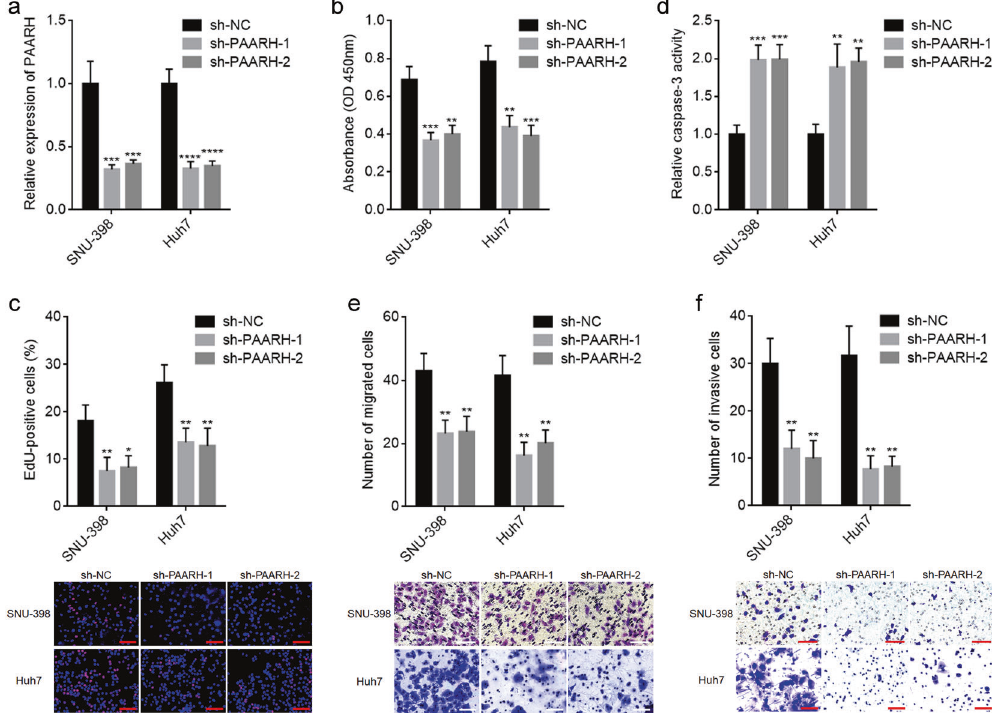
Fig. 3 PAARH silencing reduced HCC cellular malignant phenotype in vitro. a PAARH expression in SNU-398 and Huh7 cells with PAARH stable silencing was measured by qRT-PCR. b Cell growth of SNU-398 and Huh7 cells with PAARH silencing was detected using CCK-8 assays. c Cell growth of SNU-398 and Huh7 cells with PAARH silencing was detected using EdU incorporation assays. Scale bars, 100 µm. d Cell apoptosis of SNU-398 and Huh7 cells with PAARH silencing was detected using caspase-3 activity assays. e Cell migration of SNU-398 and Huh7 cells with PAARH silencing was detected using transwell migration assays. Scale bars, 100 µm. f Cell invasion of SNU-398 and Huh7 cells with PAARH silencing was detected using transwell invasion assays. Scale bars, 100 µm. Results are shown as mean ± SD based on three independent experiments. * p < 0.05, ** p < 0.01, *** p < 0.001, **** p < 0.0001 by one-way ANOVA followed by Dunnett ’ s multiple comparisons